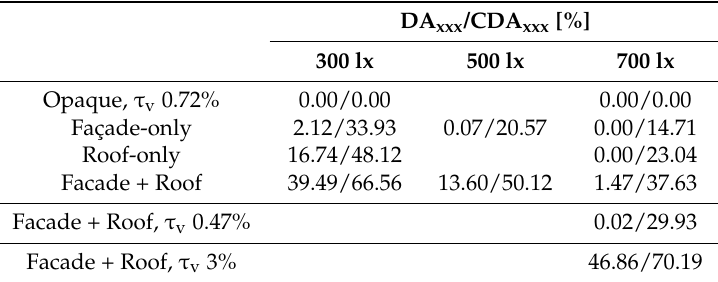
Table 7. Summary of annual daylight indicators for all